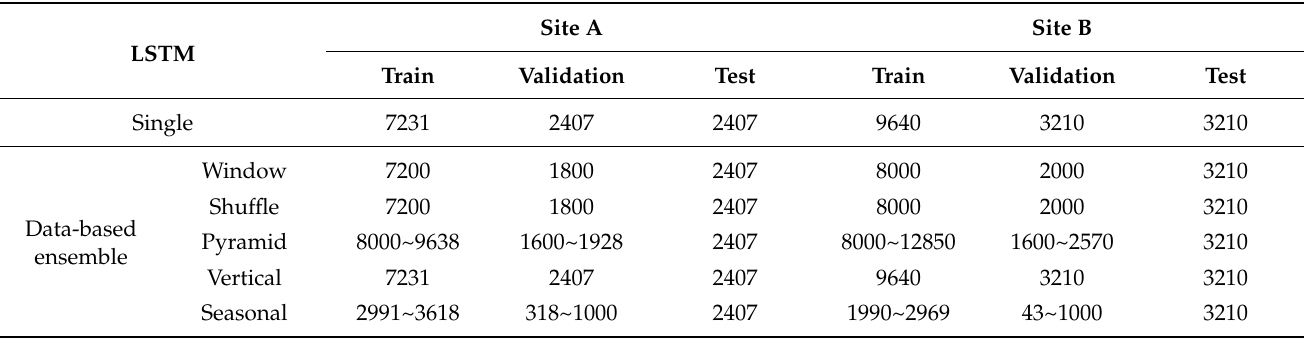
Table 4. Summary of datasets used in